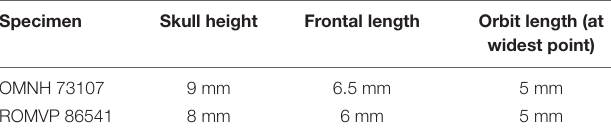
TABLE 1 | Comparative skull measurements of areas that are preserved on both the holotype and new referred specimen of Nannaroter mckinziei .